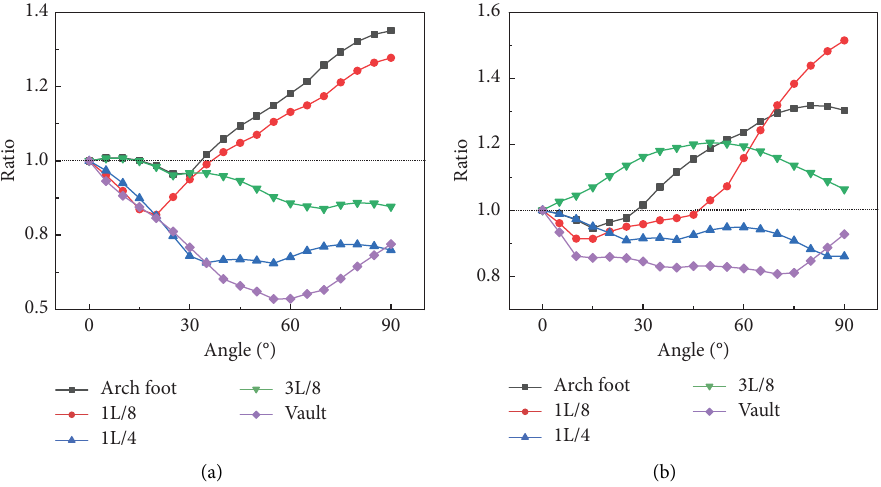
Figure 11: Upper chord axial force ratio table under 0–90 ° transformation excitation. (a) Upper chord axial force ratio diagram. (b) Lower chord axial force ratio diagram.